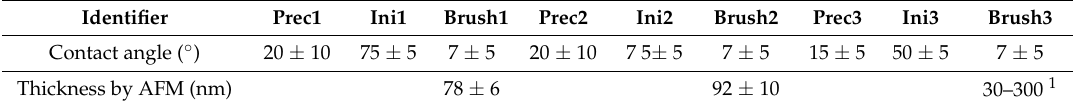
Table 1. Contact angle values and film thicknesses as determined using atomic force microscopy (AFM).